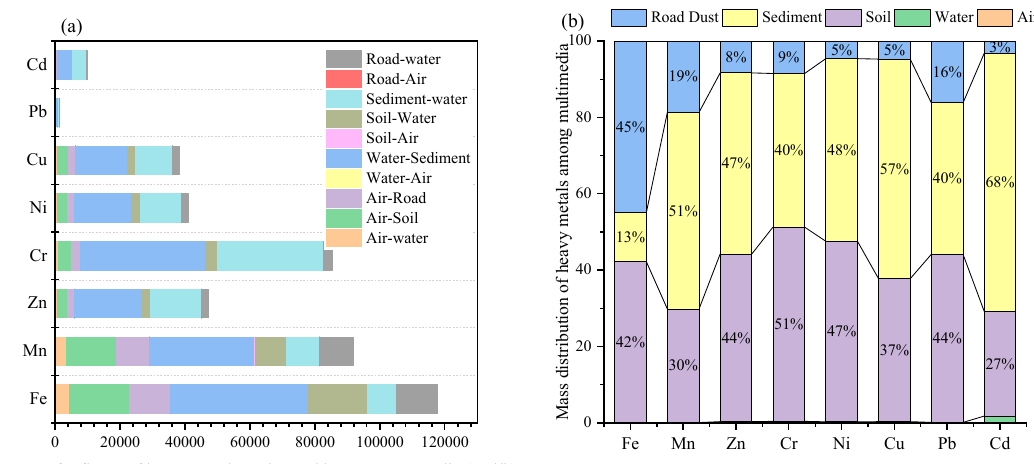
Figure 4. Transfer flux of the heavy metals exchanged between adjacent environmental media ( a ); and mass distribution of the heavy metals among the multiple media ( b